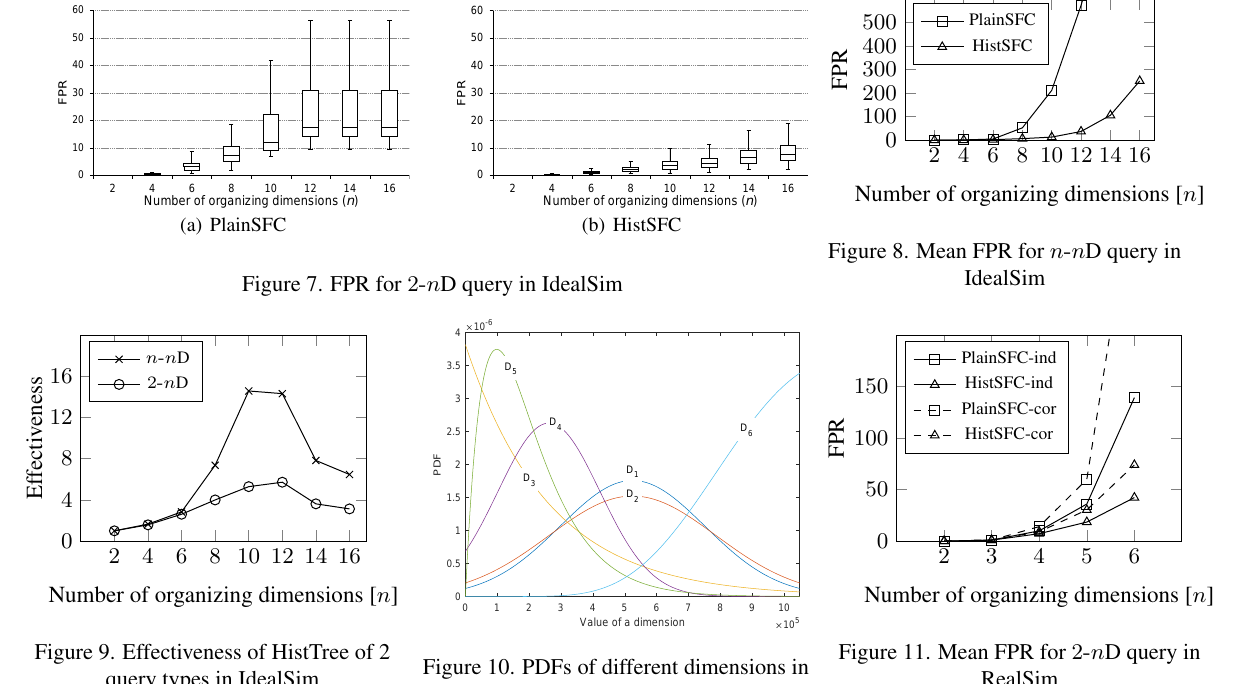
Figure 10. PDFs of different dimensions in